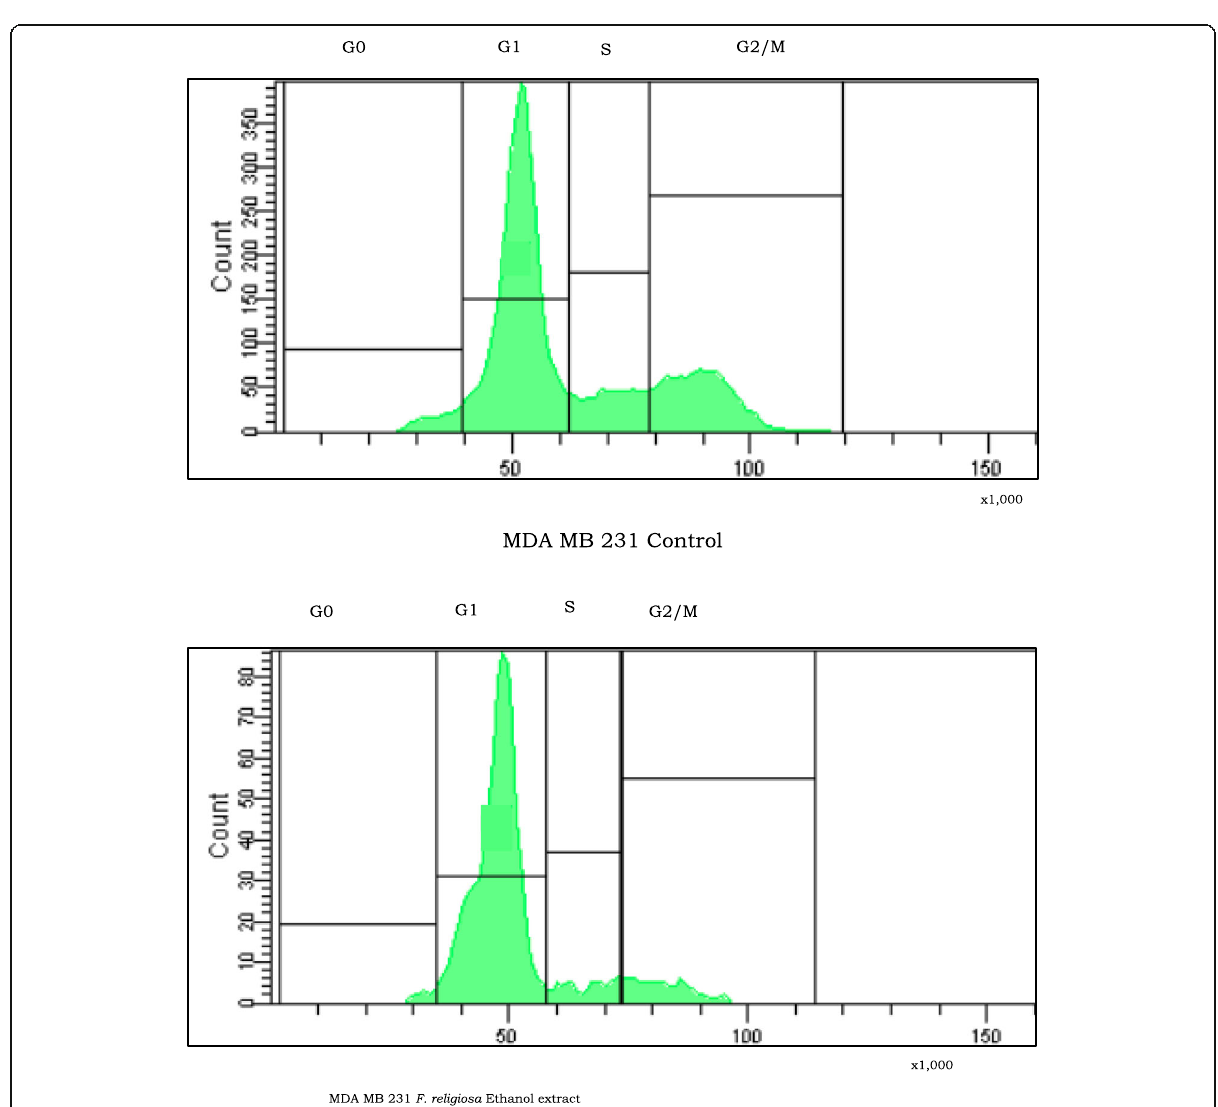
Fig. 16 Analysis of cell cycle arrest of MDA MB 231 cells when treated with IC 50 concentration of F. religiosa ethanol extract (50.86 μ g/ml) for 24 h along with control MD MB 231 cells